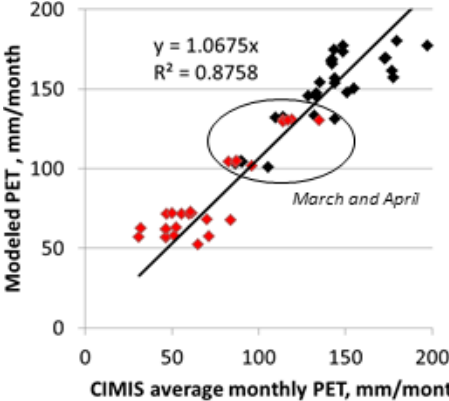
Fig. A1. Comparison of modeled potential evapotranspiration (PET) and PET measured at five stations from the California Irri- gation Management Information System (CIMIS) in the San Diego region. Red points indicate November–April, black points indicate